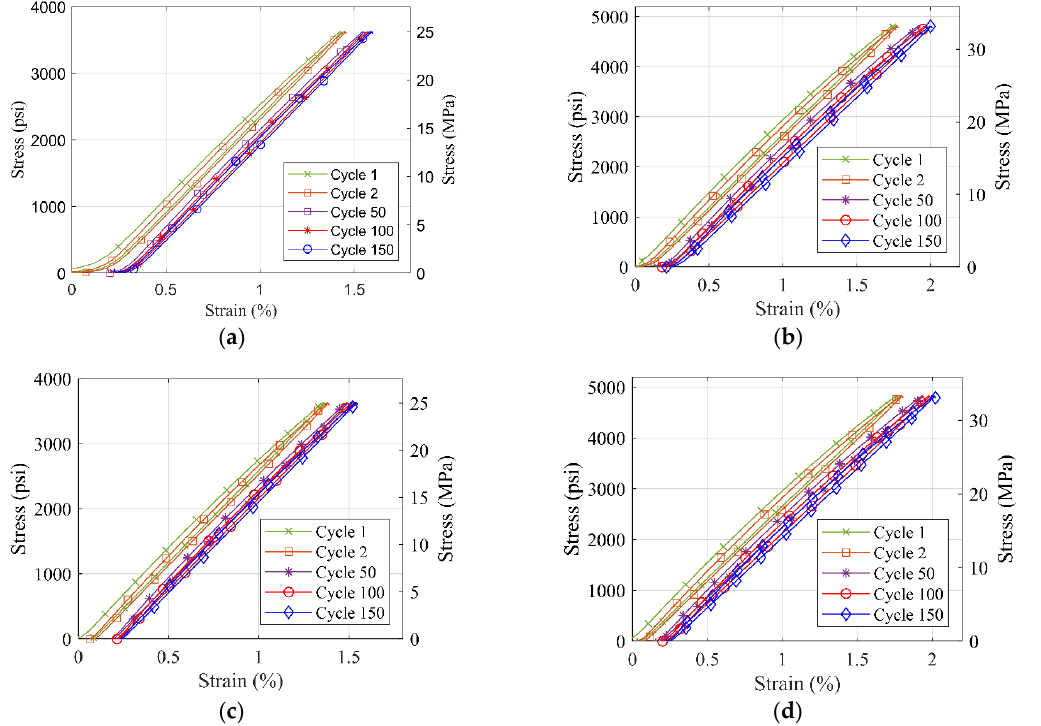
Figure 11. Stress-strain curve for fatigue testing of S7 material with ( a ) 70% of the max load for